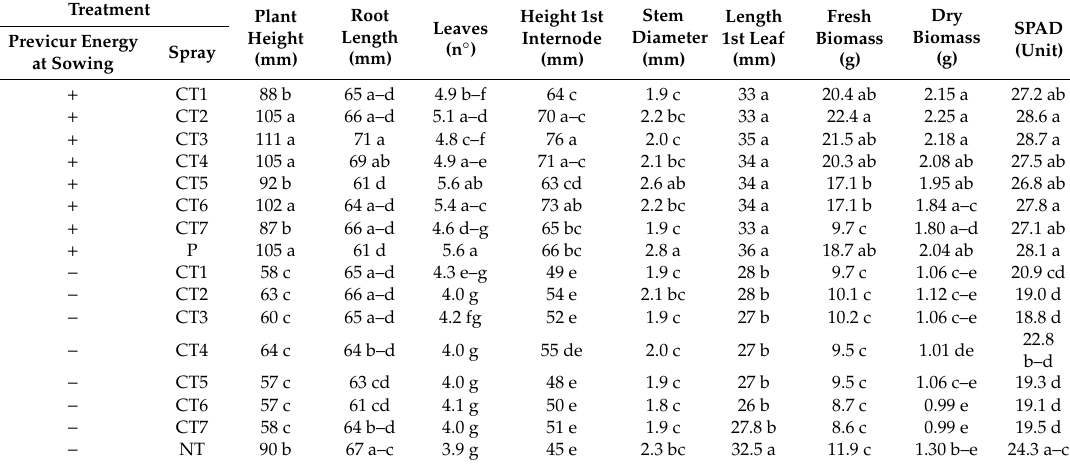
Table 5. Biometric assessments and SPAD values of pepper plants under CTs (CT1–7) produced on-farm from composts listed in Table 1, spray with or without Previcur Energy application at sowing compared with the control Previcur Energy (P) alone and no treatment (NT). Di ff erent letters indicate